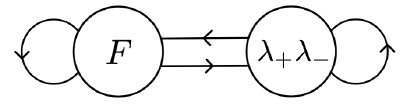
Figure 5 . Brane quiver for twisted pure N = 1 Yang-Mills. The branes are dual to gauge theory determinants det F and det λ ++ + λ −